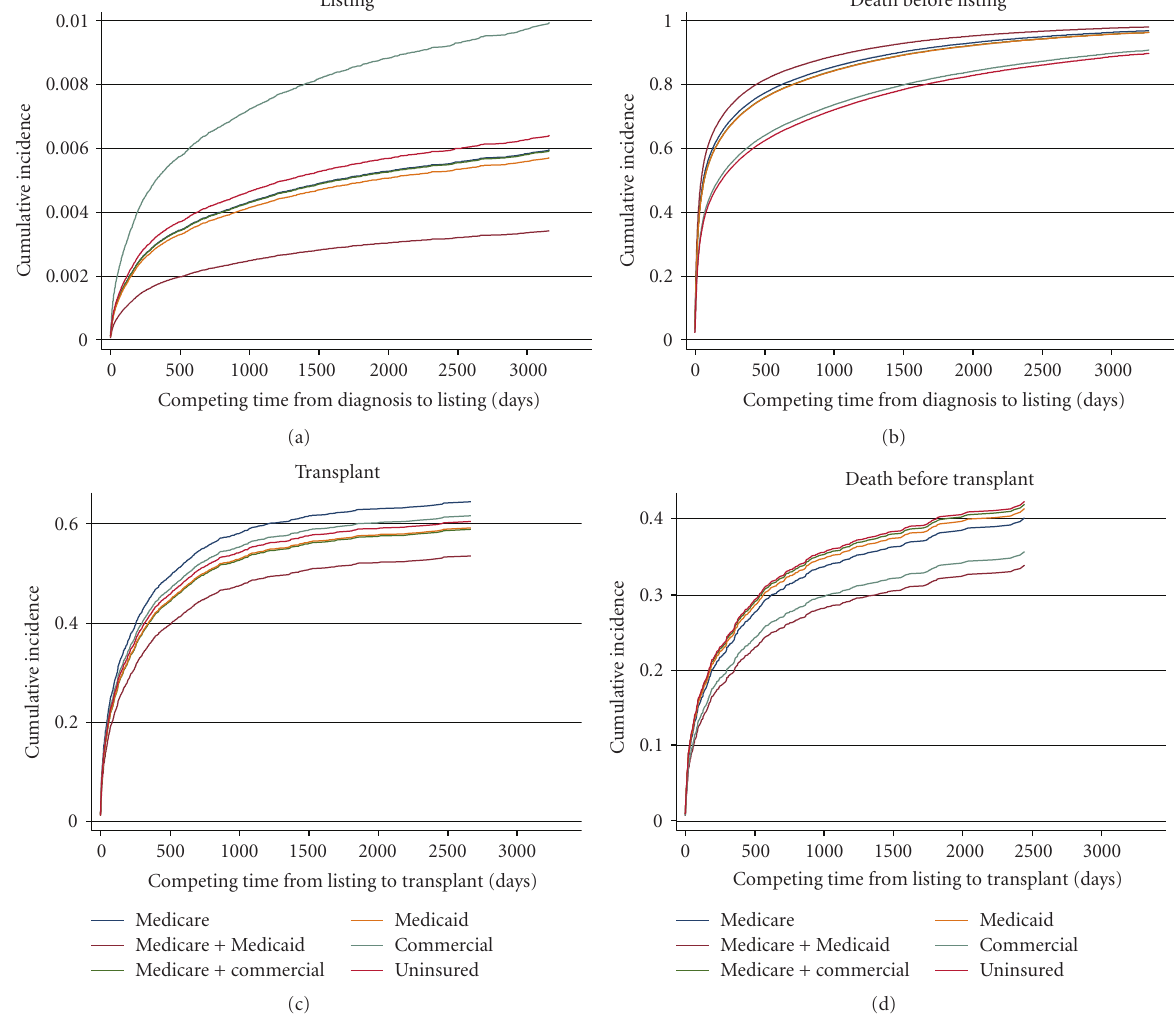
Figure 3: Insurance-based results in the adjusted competing risks